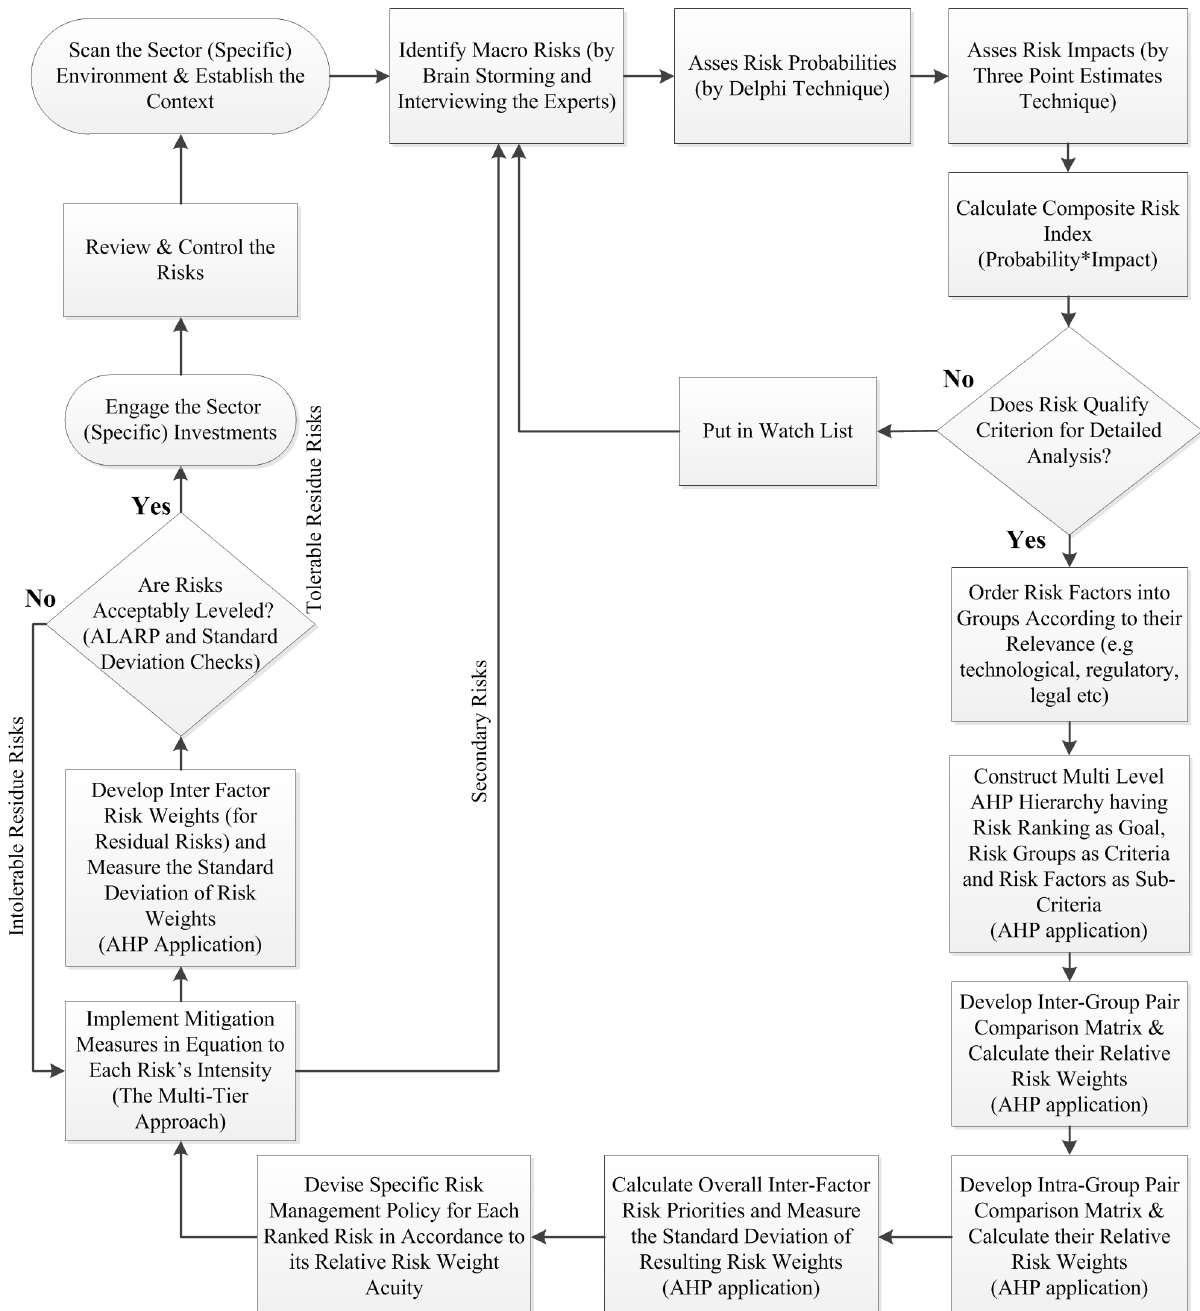
Figure 5. Risk Leveling in Business Environments